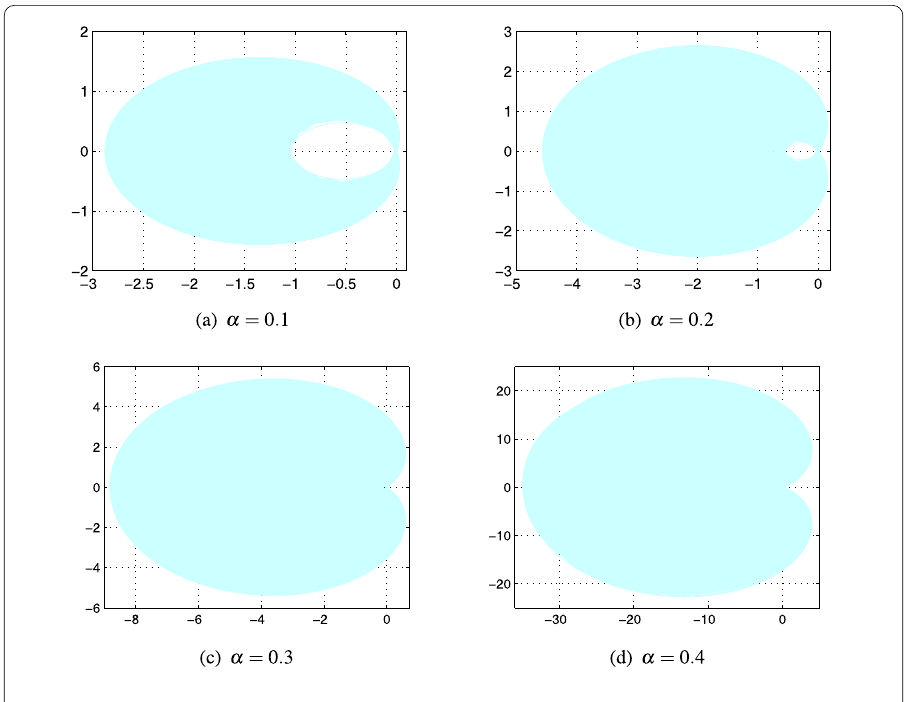
Figure 1 Stability region of numerical algorithm